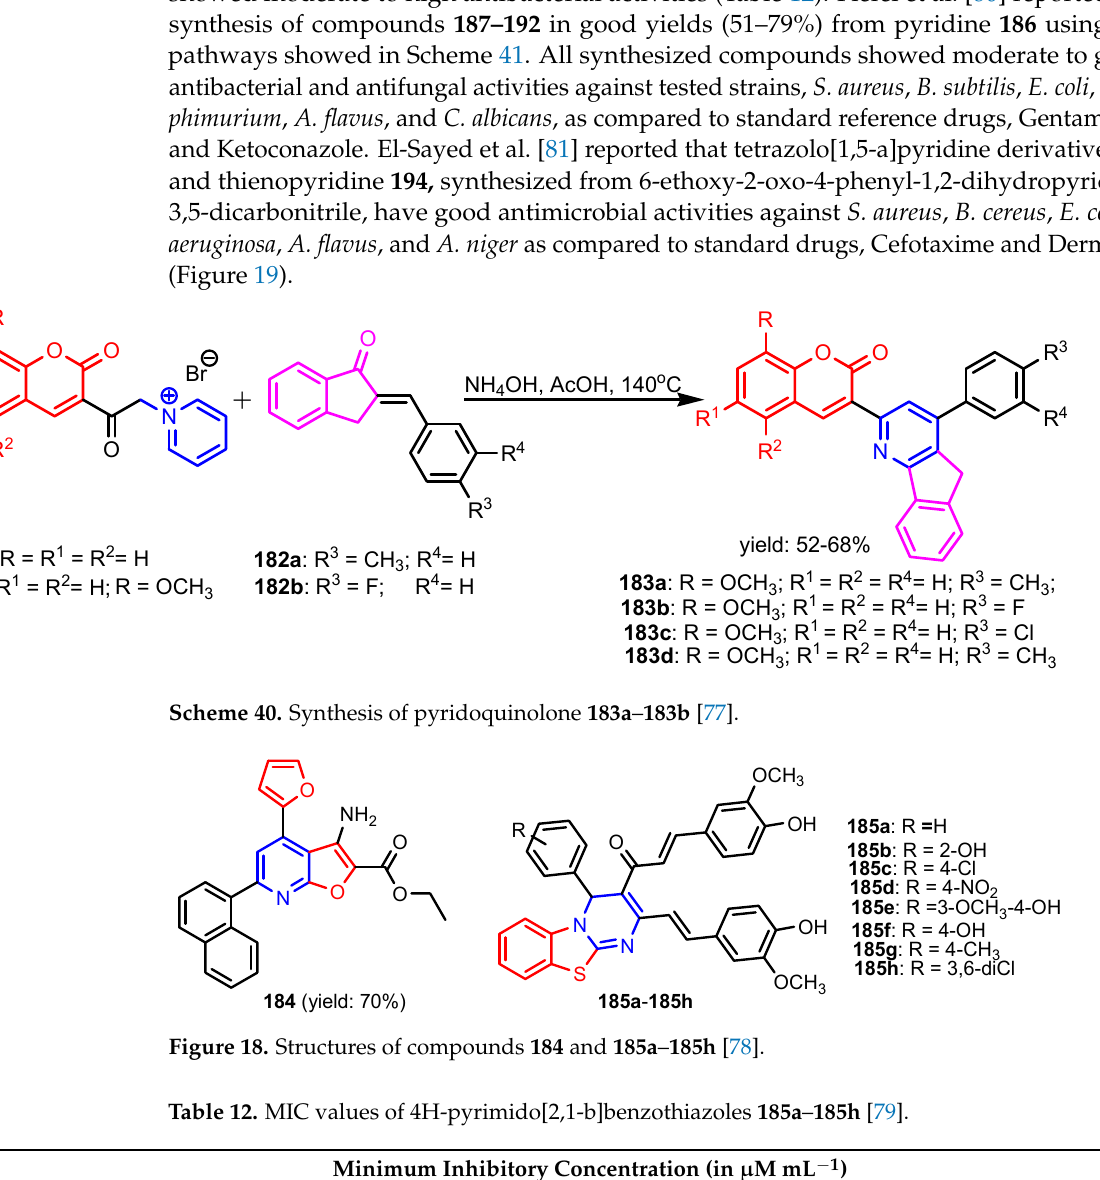
Table 12. MIC values of 4H-pyrimido[2,1-b]benzothiazoles 185a – 185h [79]. Compd.